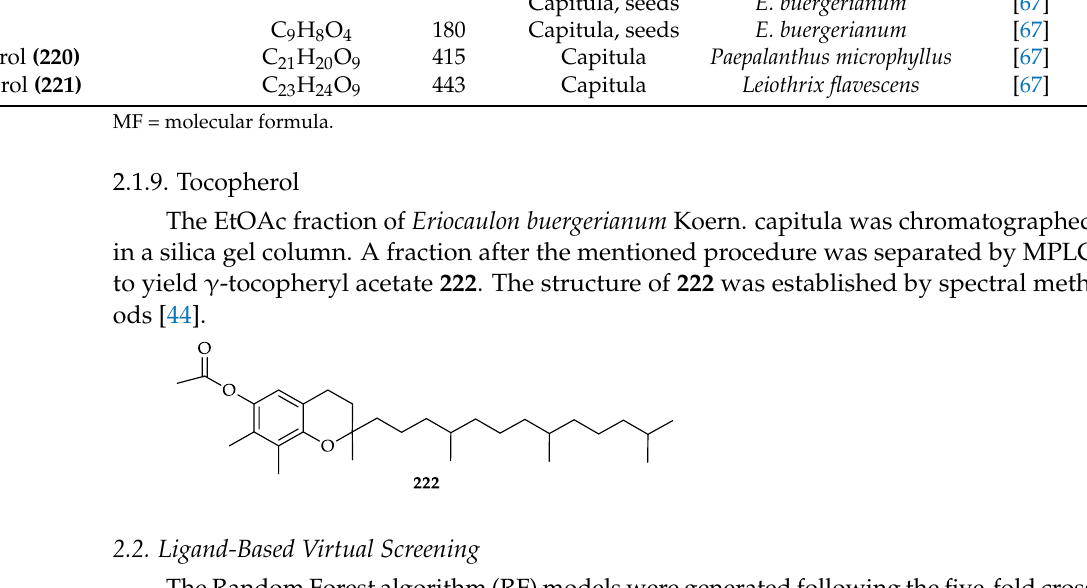
Table 9. Summary of the parameters of the results obtained in the RF models. Models MCC